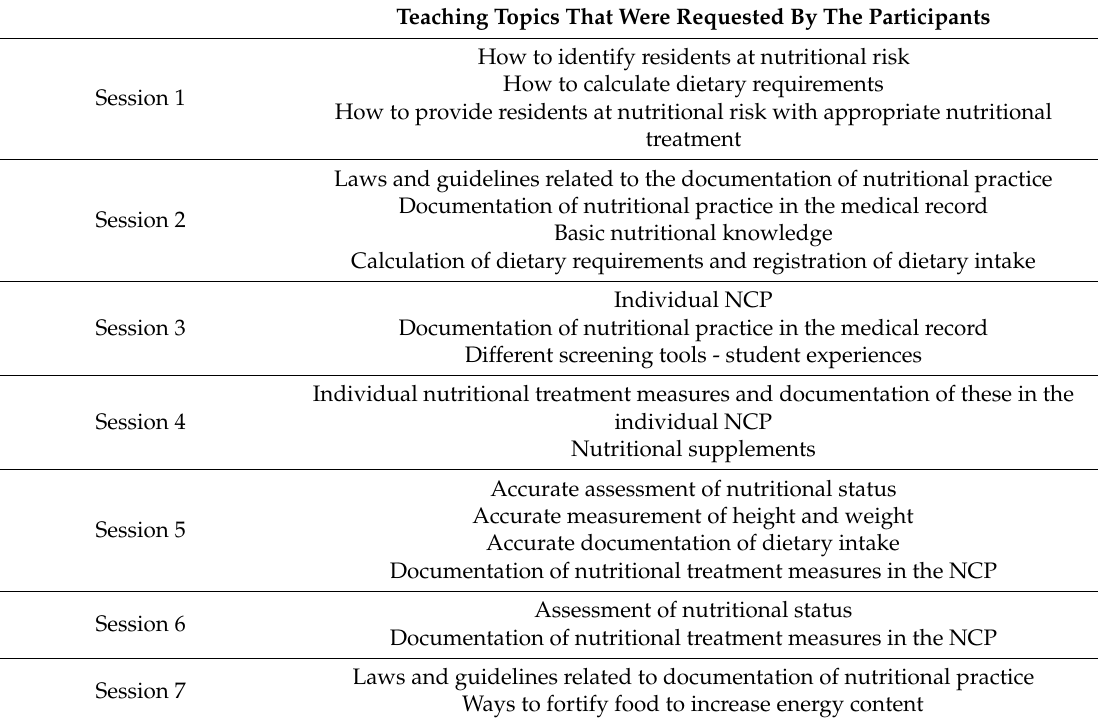
Table 1. Topics of the dialogue-based teaching sessions in the PAR